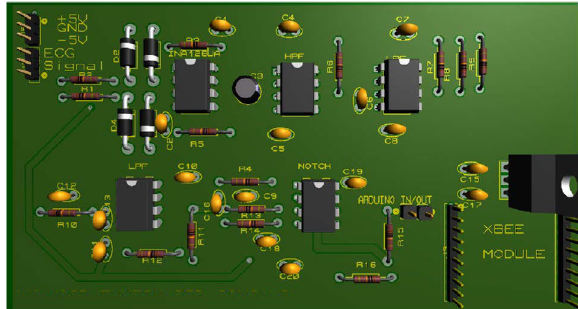
Fig. 9 The top layer of the PCB